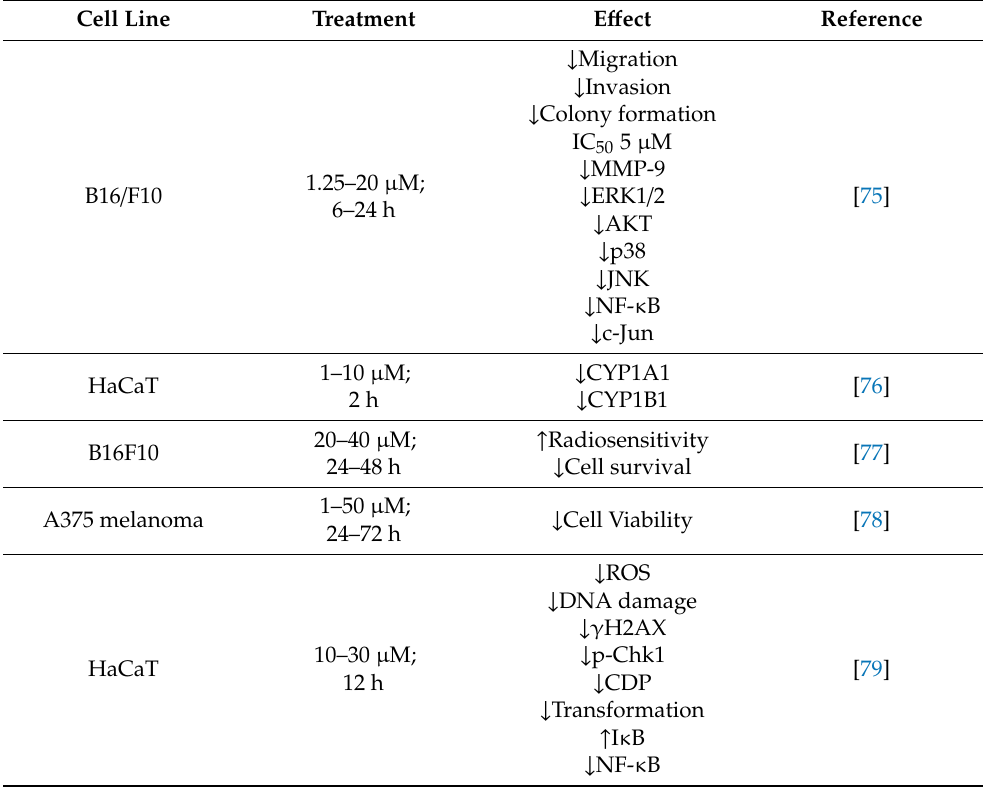
Table 9. E ff ects of carnosol on skin cancer in